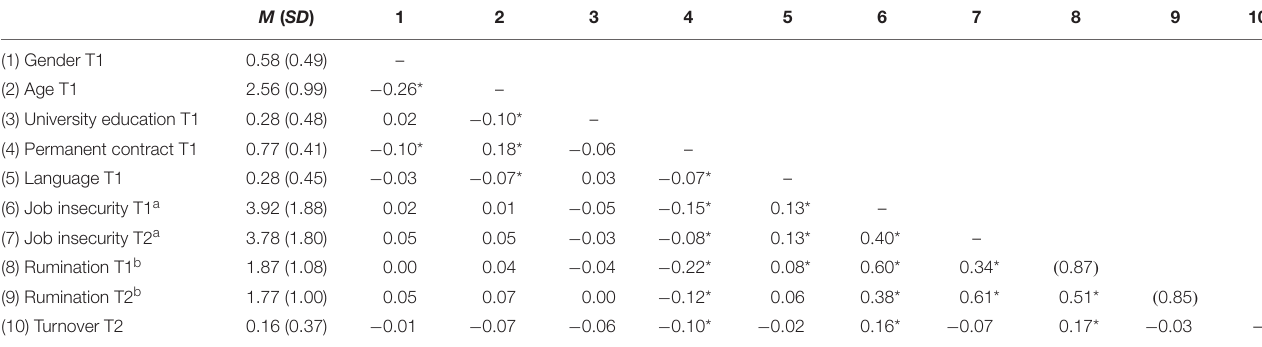
TABLE 1 | Means, standard deviations, reliability (Cronbach’s alpha coefficient in parentheses), and inter-correlation ( N = 699). M ( SD ) 1